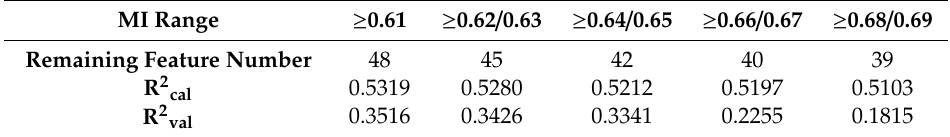
Table 5. PLSR detection results of TSS based on E-nose data with MI feature elimination.